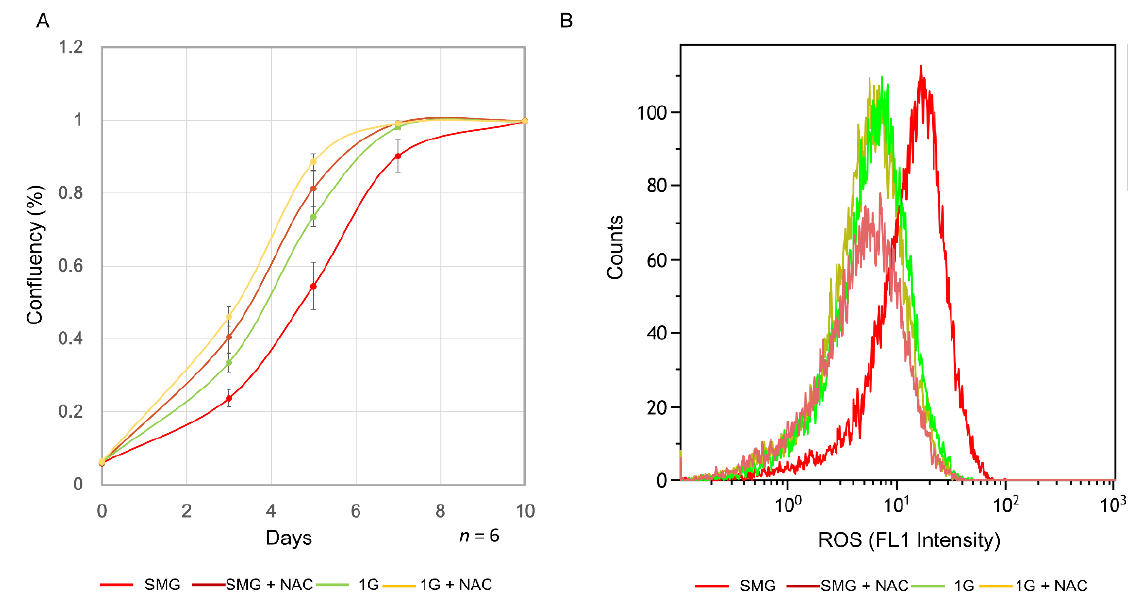
Figure 4. Evaluation of changes in oxidative stress due to simulated microgravity (SMG) exposure. ( A ) Changes in cell proliferation resulting from addition of 5 mM N-acetyl-cystein (NAC). ( B ) Evaluation of reactive oxygen species (ROS) (day 4). ROS activity was analyzed by flow cytometry at FL1 (490/525 nm) using a flow cytometer.